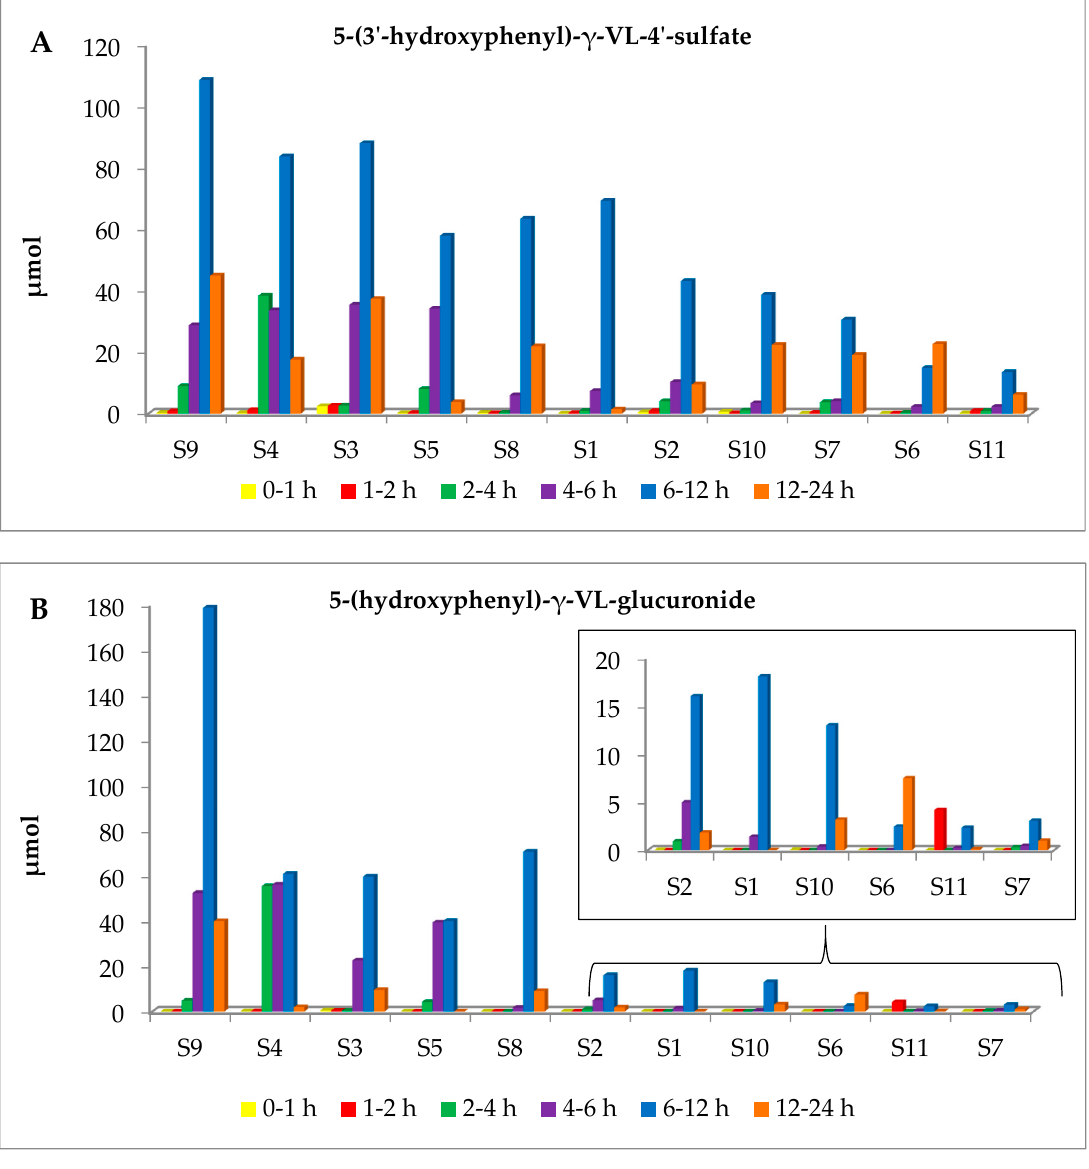
Figure 2. Urinary excretion of 5-(3'-hydroxyphenyl)- γ -VL-4'-sulfate (2) ( A ) and 5-(hydroxyphenyl)- γ -VL-glucuronide (4) ( B ) in the 11 study subjects (S1–S11) at different time intervals. 0–1 h: yellow bars; 1–2 h: red bars; 2–4 h: green bars; 4–6 h: purple bars; 6–12 h: blue bars; 12–24 h: orange bars. Subjects are shown in decreasing order of cumulative excretion in urine (AUC). Data were normalized according to urine volume .